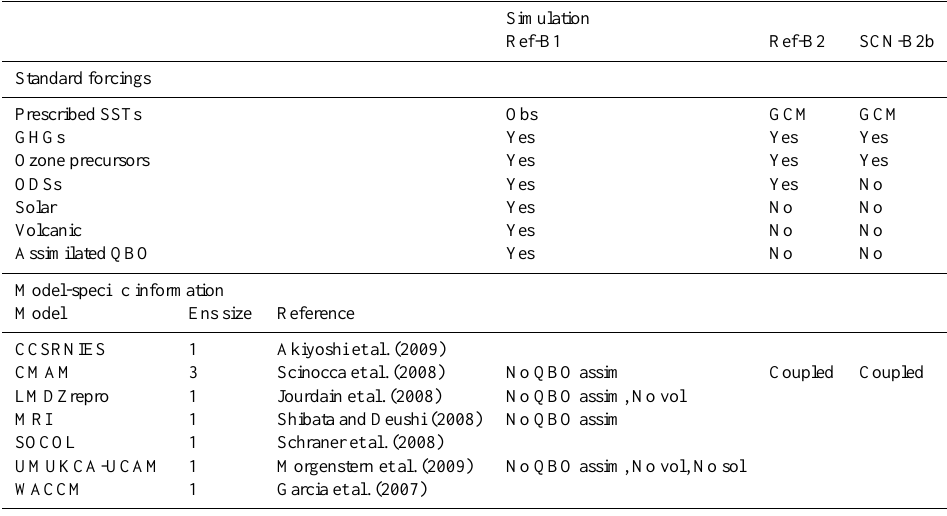
Table 1. CCMVal simulations used. The maximum possible ensemble size “Ens size” was chosen for each model such that the ensemble size was the same for all three simulations, in order to avoid aliasing model differences into differences between multi-model means of simulations with different forcings. “No QBO assim” indicates that no QBO was assimilated. MRI and UMUKCA-UCAM have an internally generated QBO, and CMAM and LMDZrepro do not simulate the QBO. “No vol” indicates that direct radiative effects of volcanic aerosol were not included, although the chemical effects were included in all models. “No sol” indicates that no solar cycle was specified. “Coupled” indicates that the atmosphere model was coupled to a dynamical ocean model.“GHGs” refers to to the greenhouse gases carbon dioxide, methane and nitrous